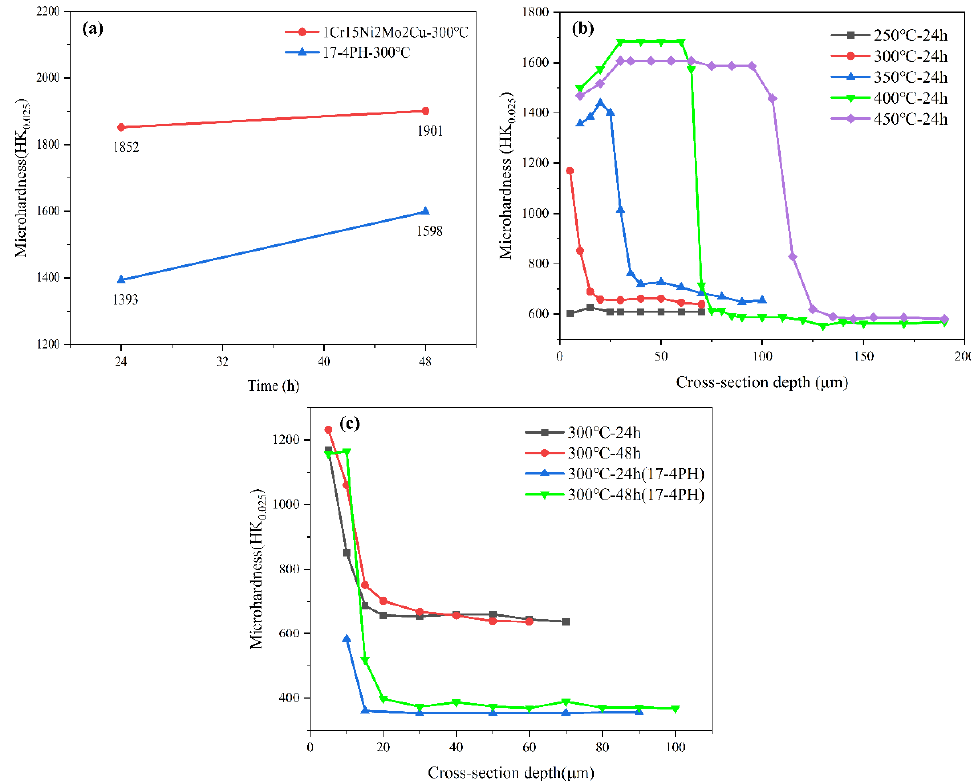
Figure 8. Surface and section hardness of stainless steel after plasma nitriding. ( a ) Surface hardness of nitrided samples at different temperatures and holding times. ( b ) Section hardness of 1Cr15 nitrided samples at different temperatures. ( c ) Section hardness of nitrided samples at different temperatures and holding times.